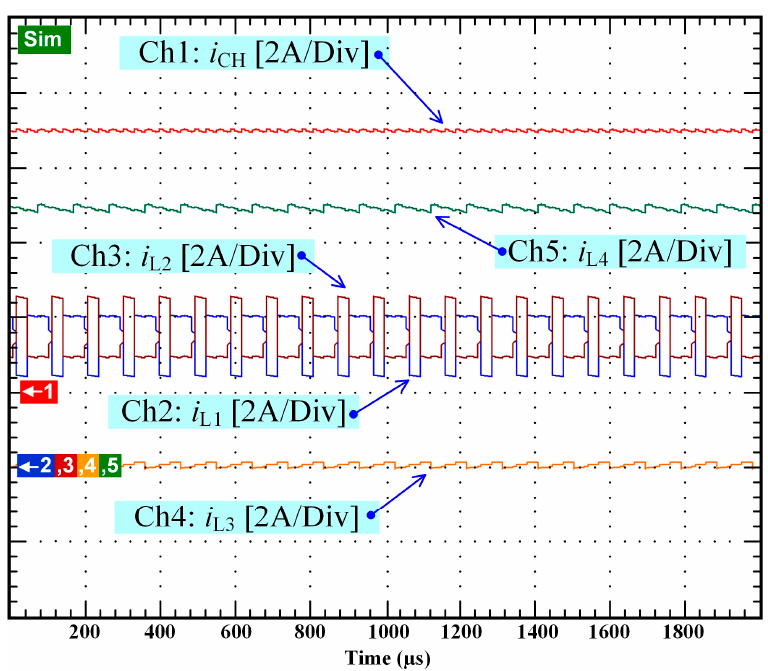
Figure 7. Simulation results: TLIBC performance with re-phase technique only.